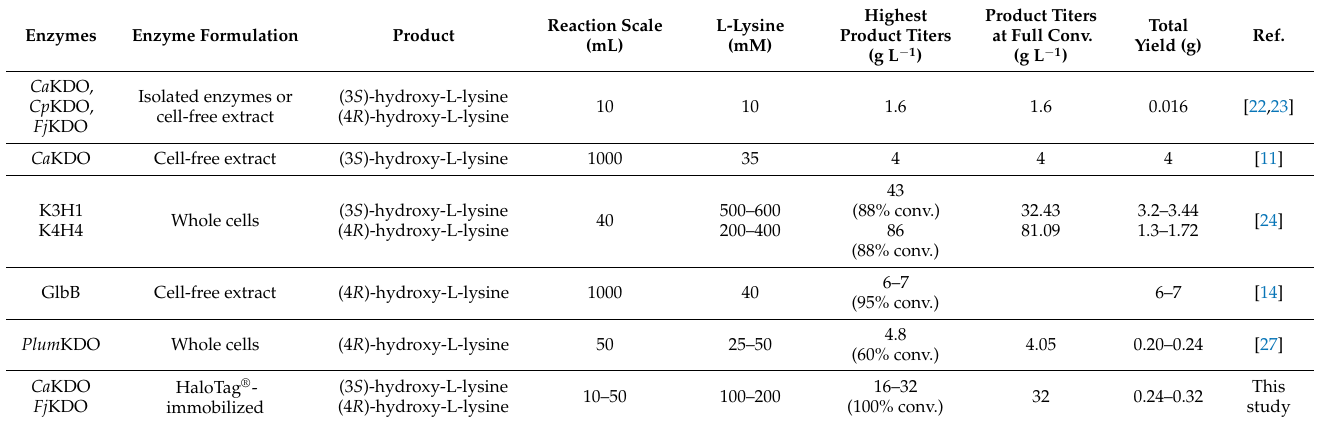
Table 1. Comparison of process parameters of previously published KDO-catalyzed biotransforma- tions towards hydroxy-L-lysines in a preparative lab